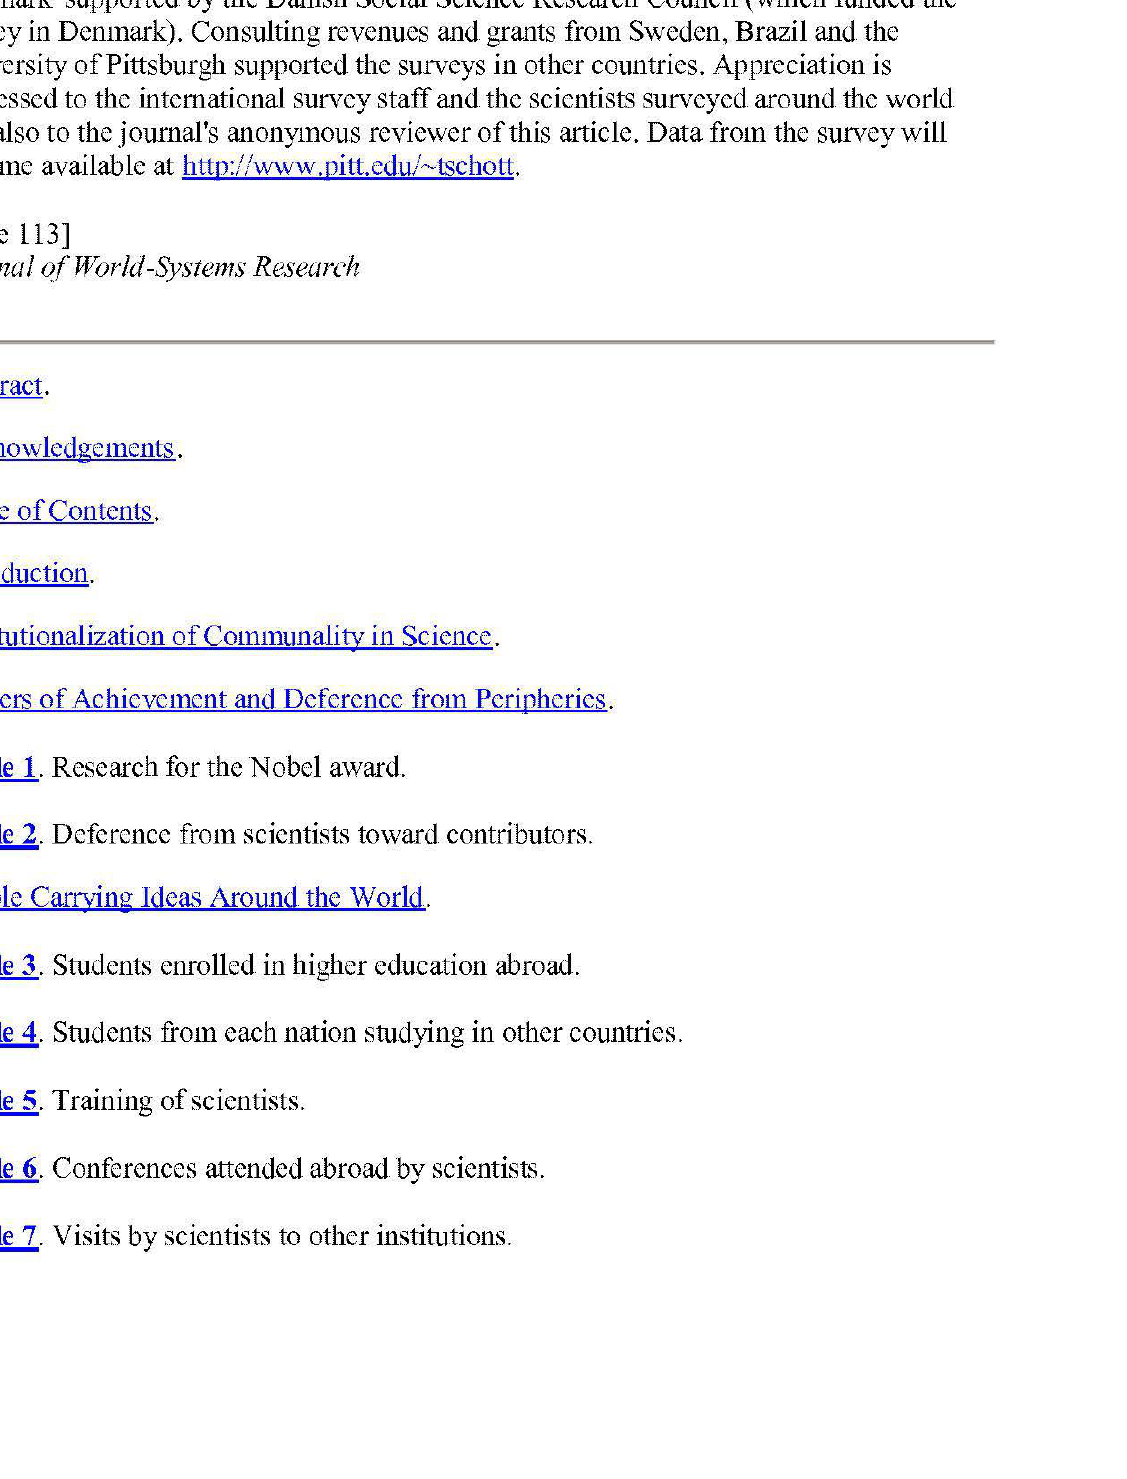
Table 1. Research for the Nobel award. Table 2 . Deference from scientists toward contributors. People Carrying Idea<; Around the World . Table 3 . Students enrolled in higher education abroad. Table 4 . Students from each nation studying in other countries. Table 5. Training of scientists. Table 6. Conferences attended abroad by scientist<;. Table 7. Visits by scientists to other